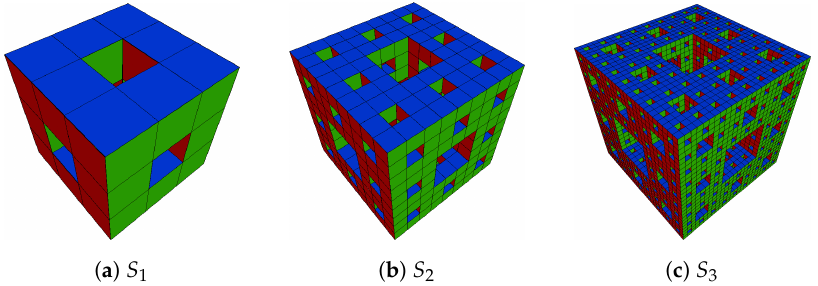
Figure 8. First three levels of the Menger sponge fractal.